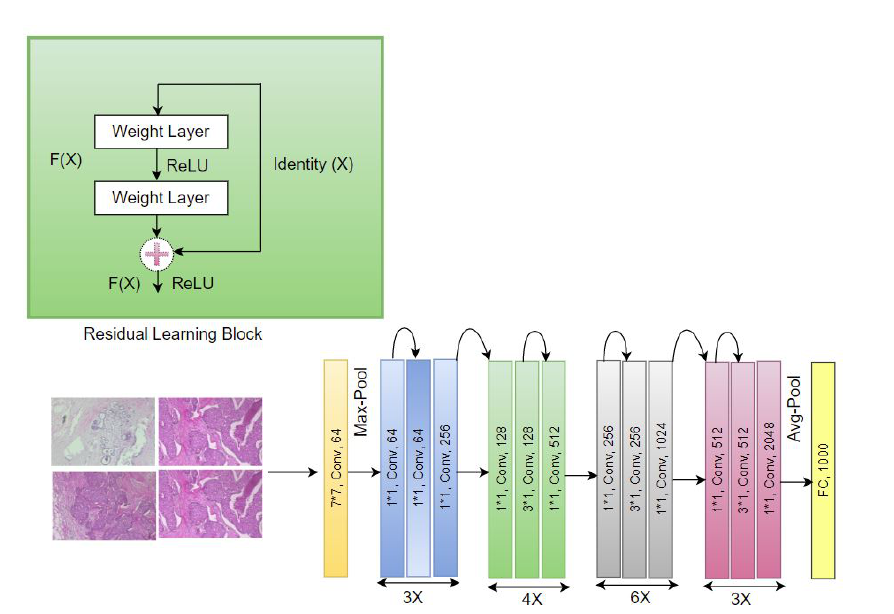
Figure 5. Resnet-50 CNN